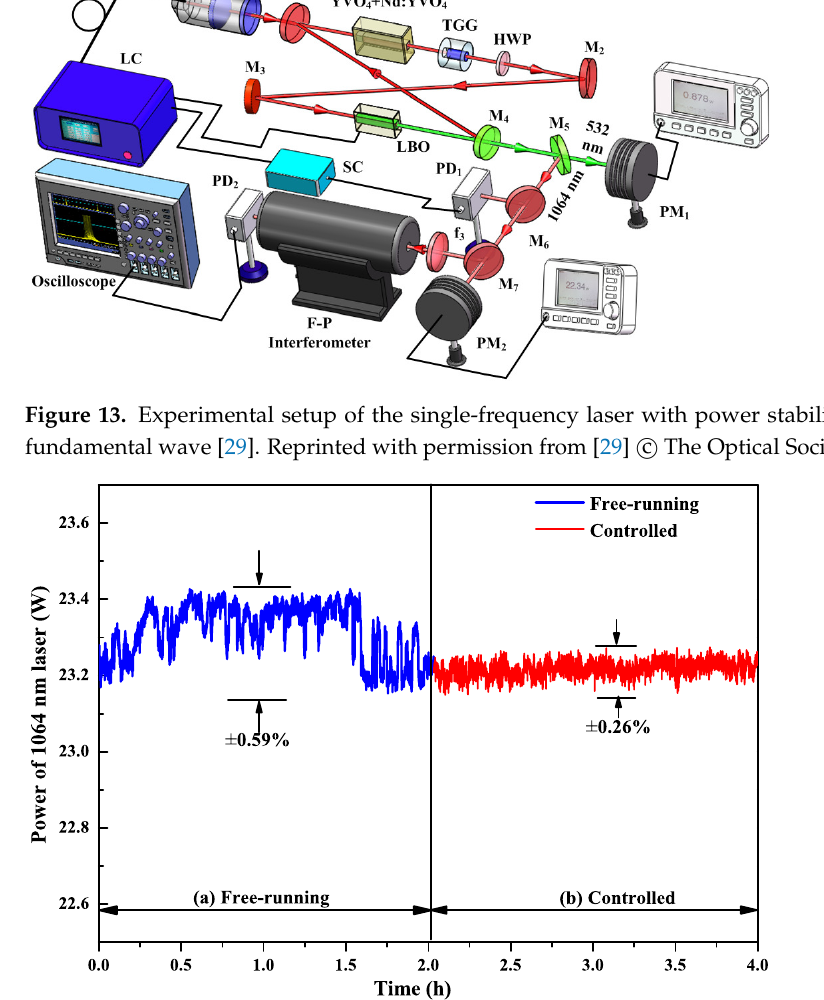
Figure 14. Power stability of 1064 nm laser in 4 h with two phases: ( a ) free-running phase and ( b ) controlled phase [29]. Reprinted with permission from [29] c (cid:13) The Optical